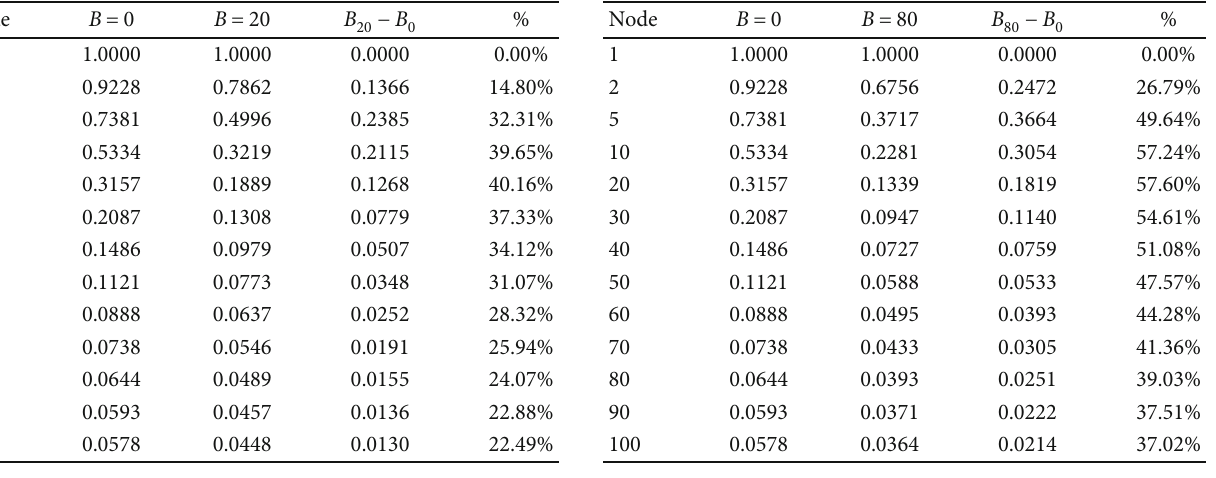
Table 2: Comparison of radiation values B = 40 . Node